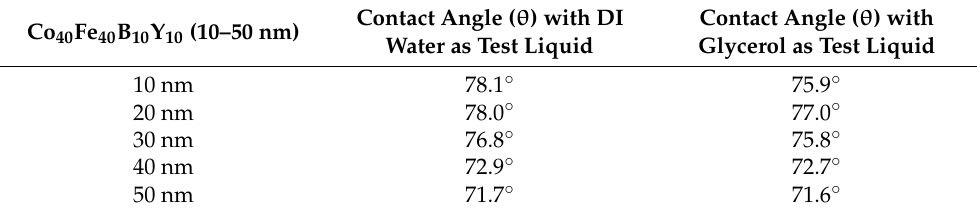
Table 6. Average contact angles of CoFeBY nanofilms after annealing at 300 ◦ C with DI water and